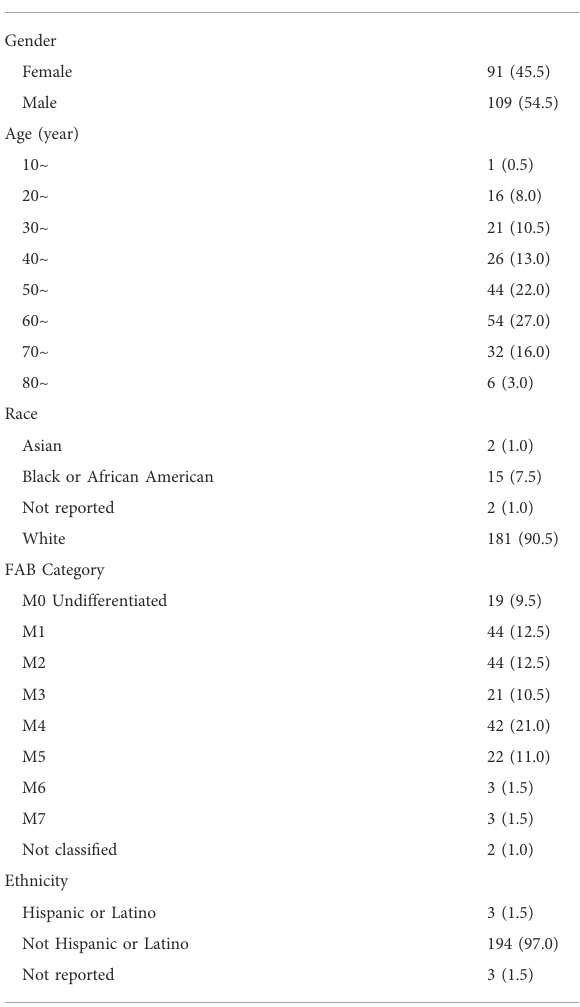
TABLE 1 Baseline characteristics for 200 patients with AML in the TCGA